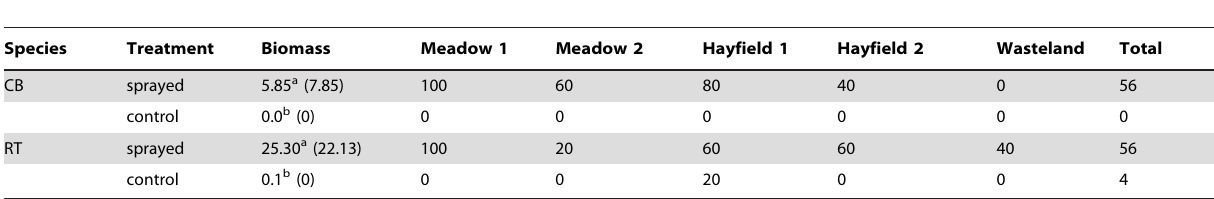
Table 2. Mean bentgrass biomass (g dry weight) and survivorship (percent) for introduced creeping bentgrass (CB) and redtop (RT) plants at the end of the field experiment (2010).